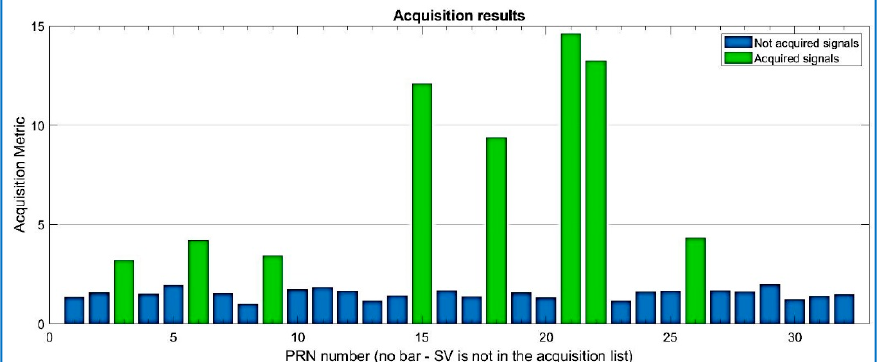
Figure 9. Acquired PRNs from Dataset 1, with R = 0.025.